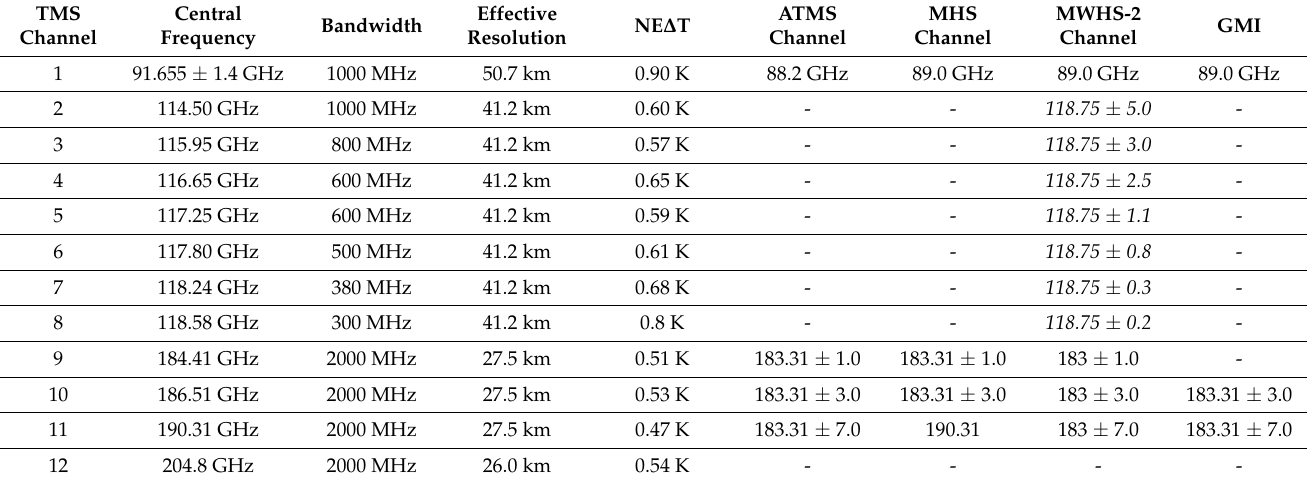
Table 1. TMS channel sets together with similar frequencies from current operational sensors (figures in italics indicate approximate matches). The TMS noise equivalent delta temperature (NE ∆ T) quoted is from on-orbit Pathfinder analysis. Note that while most sounding instruments provide measurements on either side of the center line of an absorption band, the TMS only provides a single-sided measurement (i.e., 183.31 ± 3.0 ∼ = 183.31 +